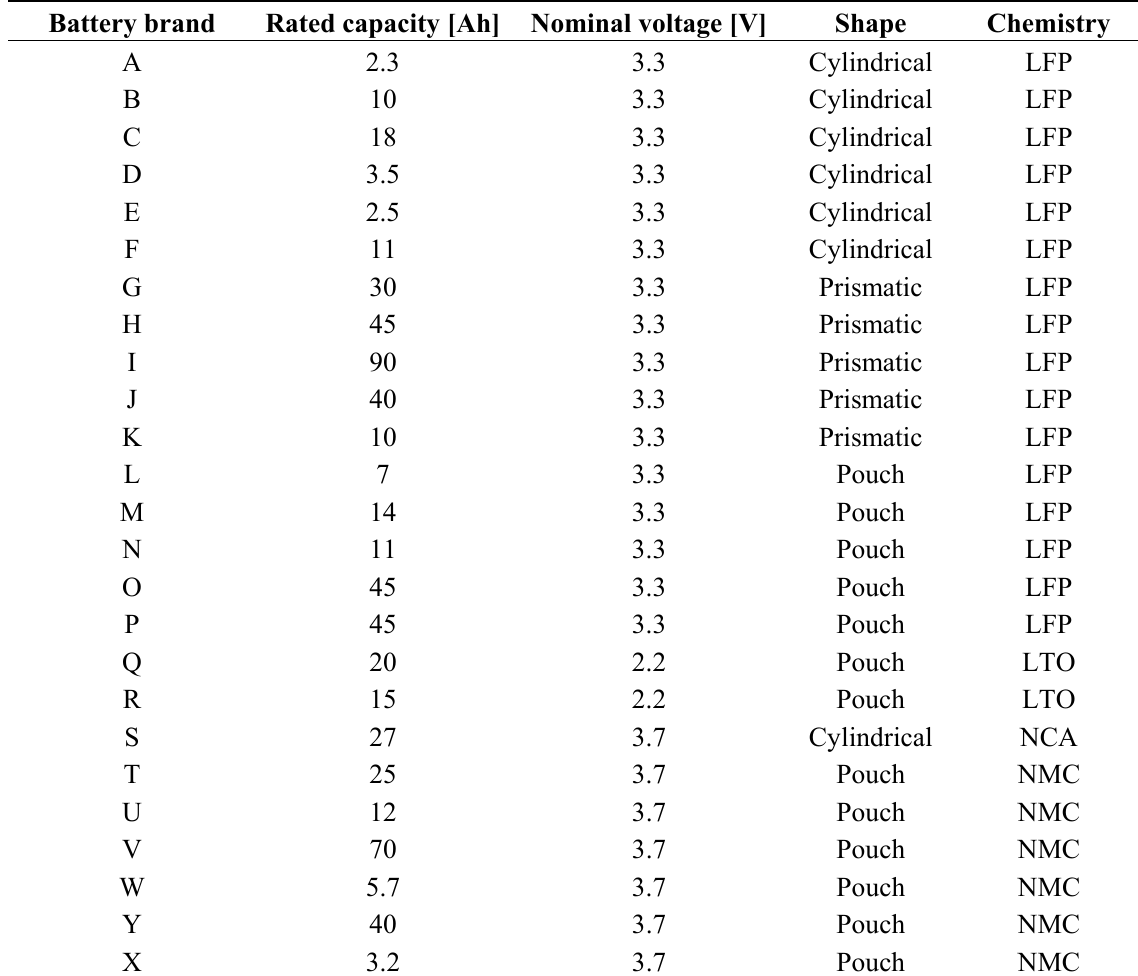
Table 3. Specifications studied lithium-ion